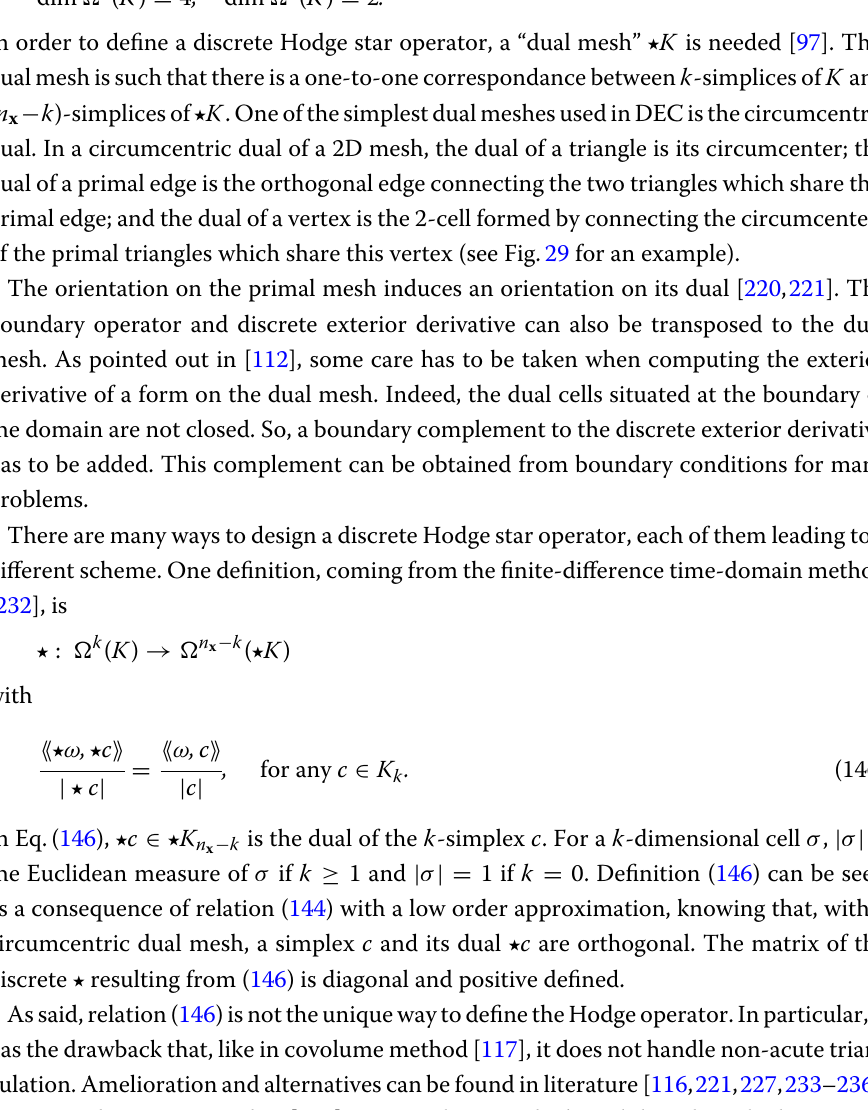
For example, with the mesh on Fig. 27, n x = 2